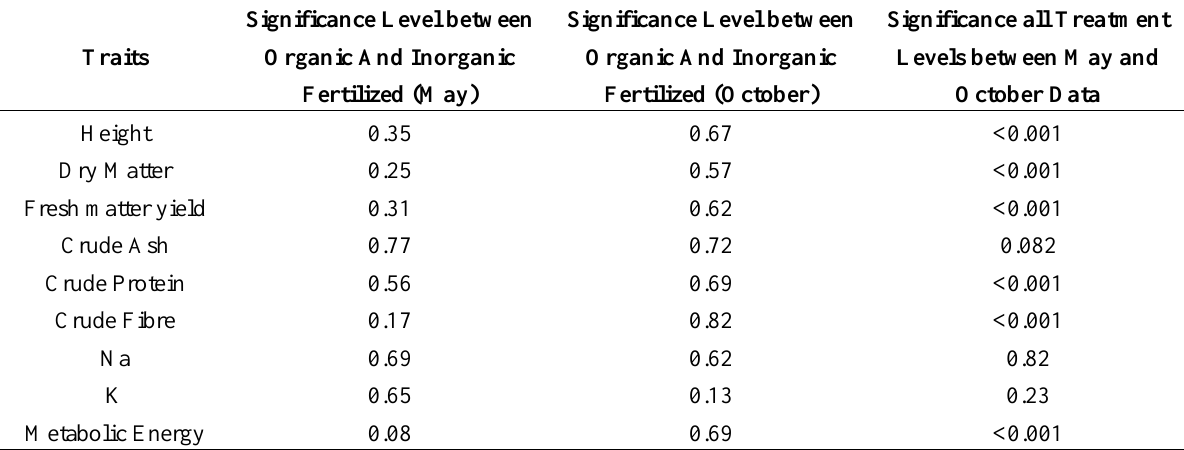
Table 5. Significance level obtained by applying the t -test between organic and inorganic treatments in May, in October, and between May and October